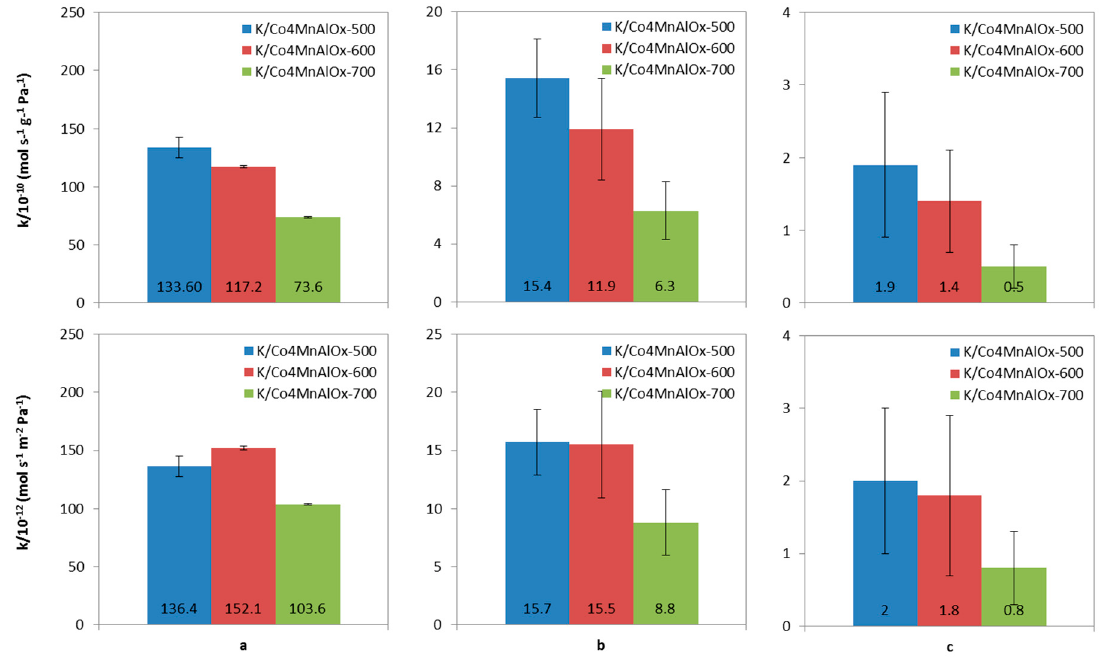
Figure 7. Kinetic constants of N 2 O catalytic decomposition at different reaction atmospheres (390 °C) over K/Co 4 MnAlO x mixed oxide calcined at different temperatures. Legend: ( a ) 0.1 mol. % N 2 O balanced by He; ( b ) 0.1 mol. % N 2 O + 5 mol. % O 2 + 0.9 mol. % H 2 O balanced by He; ( c ) 0.1 mol. % N 2 O + 5 mol. % O 2 + 3 mol. % H 2 O + 0.01 mol. % NO + 0.01 mol. % NO 2 balanced by He.